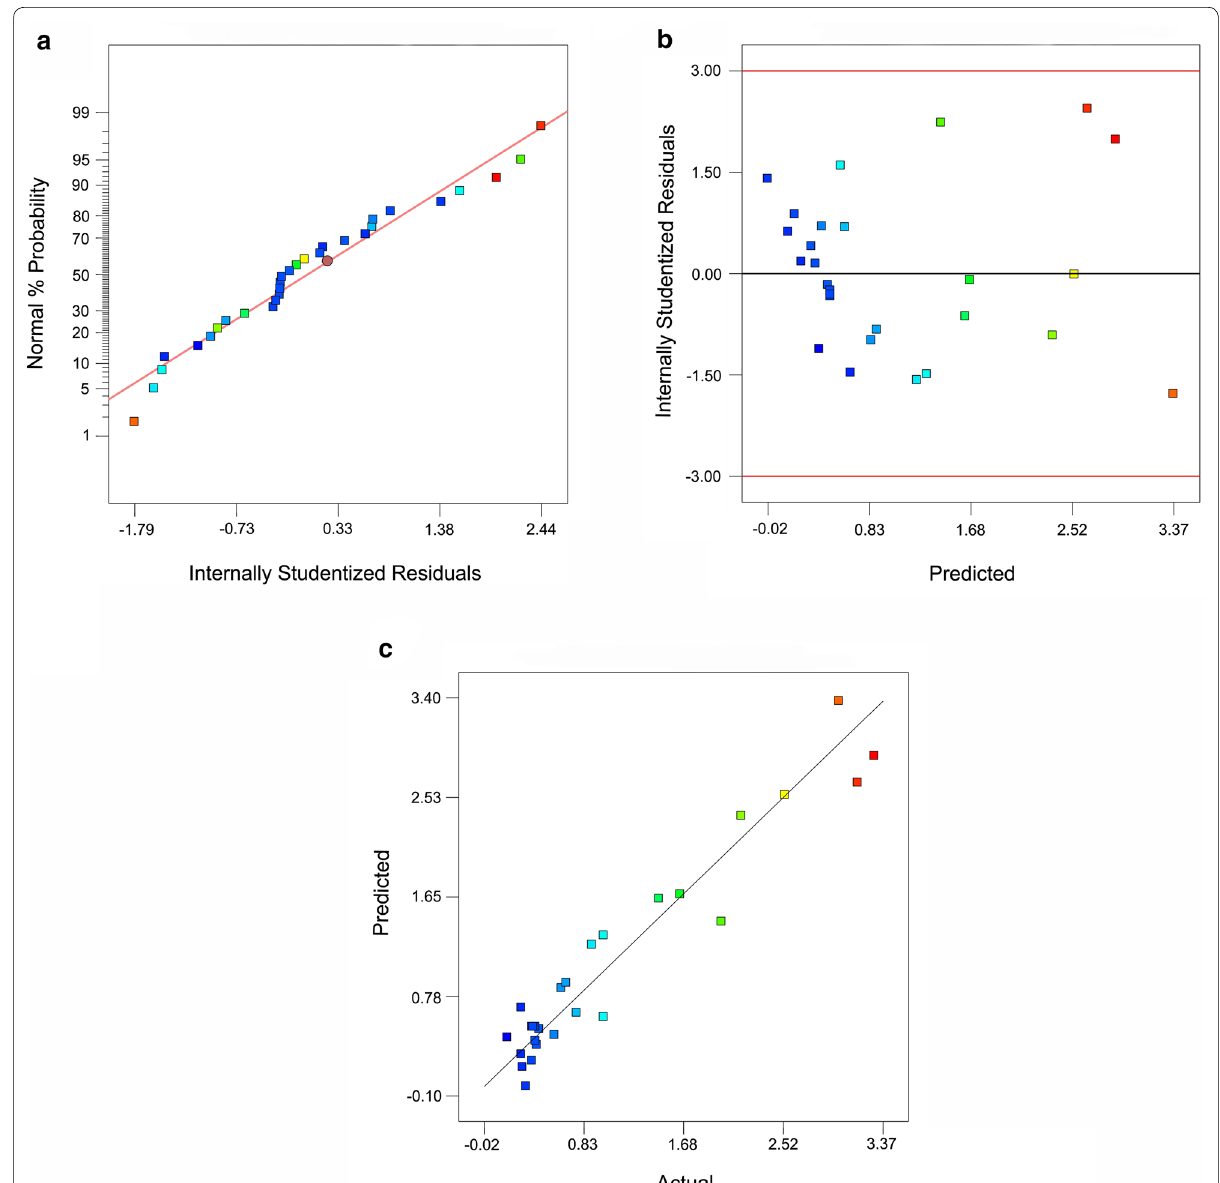
Fig. 3 The studentized residual plots for the quadratic model adequacy. The normal plot of residuals ( a ), the plot of internally studentized residuals vs predicted response ( b ), and the plot of internally studentized residuals vs actual ( c